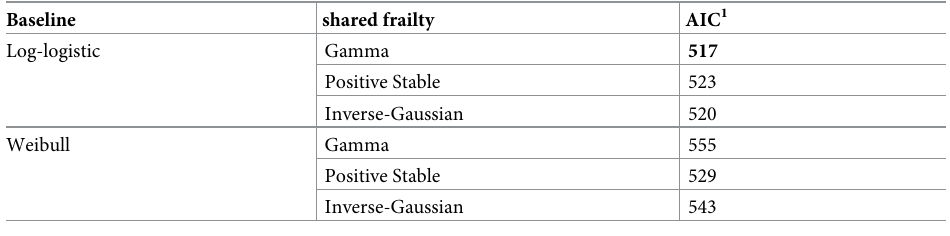
Table 7. The value of AIC for parametric shared frailty models, LPAC, 2015–2019.